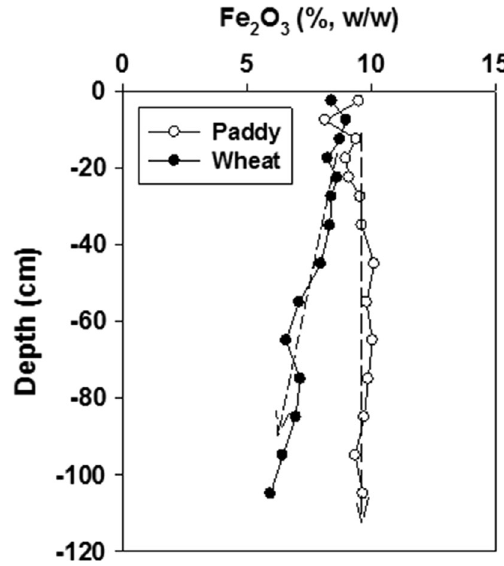
Fig. 3 Variation in Fe concentrations (as Fe paddy and wheat soil profile. The dashed arrows indicate the trend of Fe concentration with depth